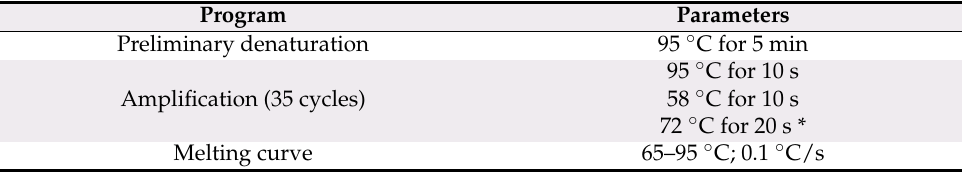
Table 2. Conditions of the RT-qPCR for the reference genes (*).